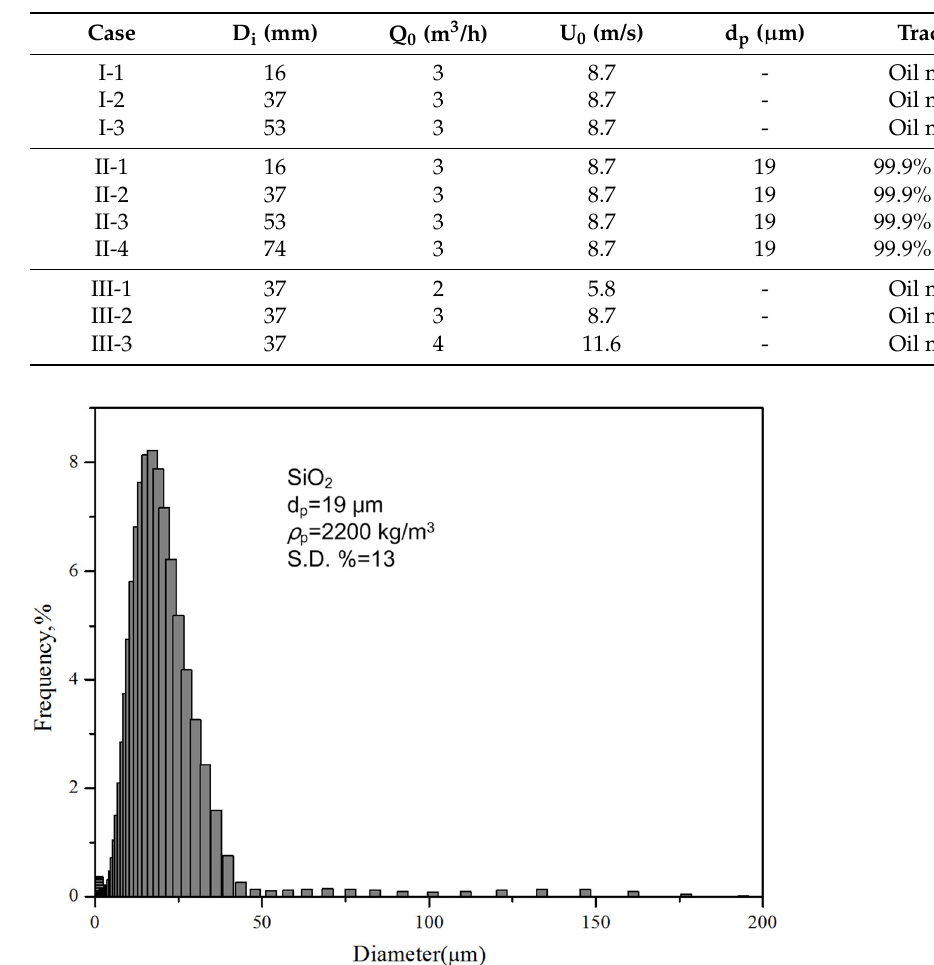
Figure 2. The measured particle size distribution and main material parameters.